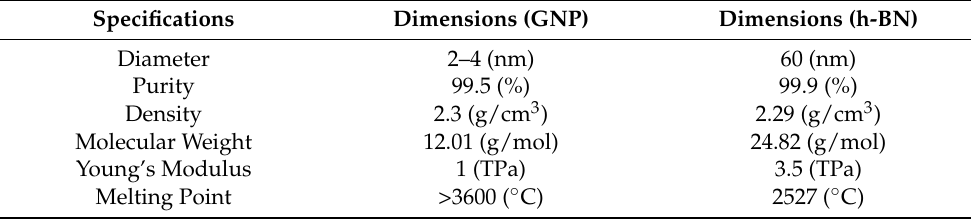
Table 1. Properties of the GNP and h-BN used in this study.